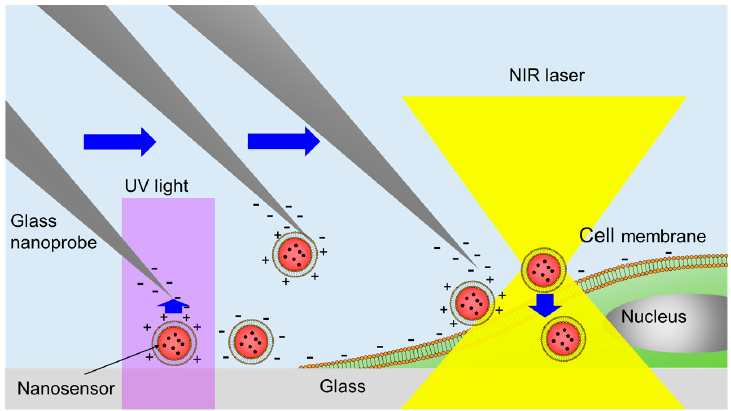
Figure 1. Schematic diagram of the manipulation and cell injection of a single nanosensor using optical control of the zeta potential. NIR: Near-infrared.